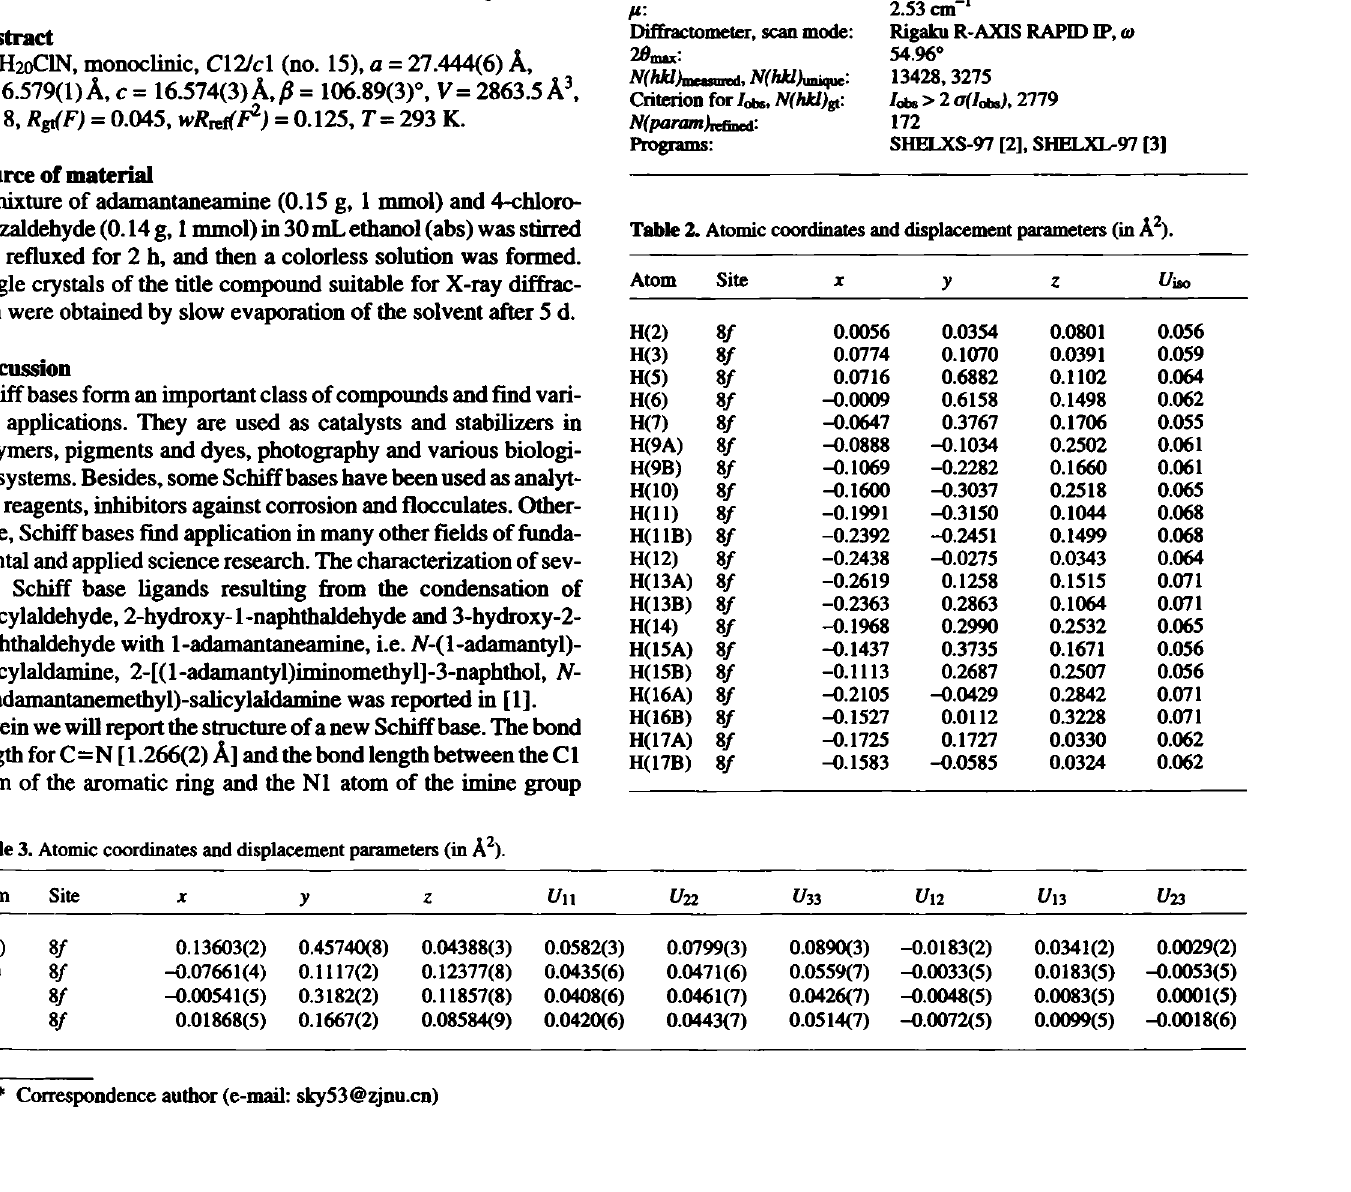
Table 1. Data collection and handling.